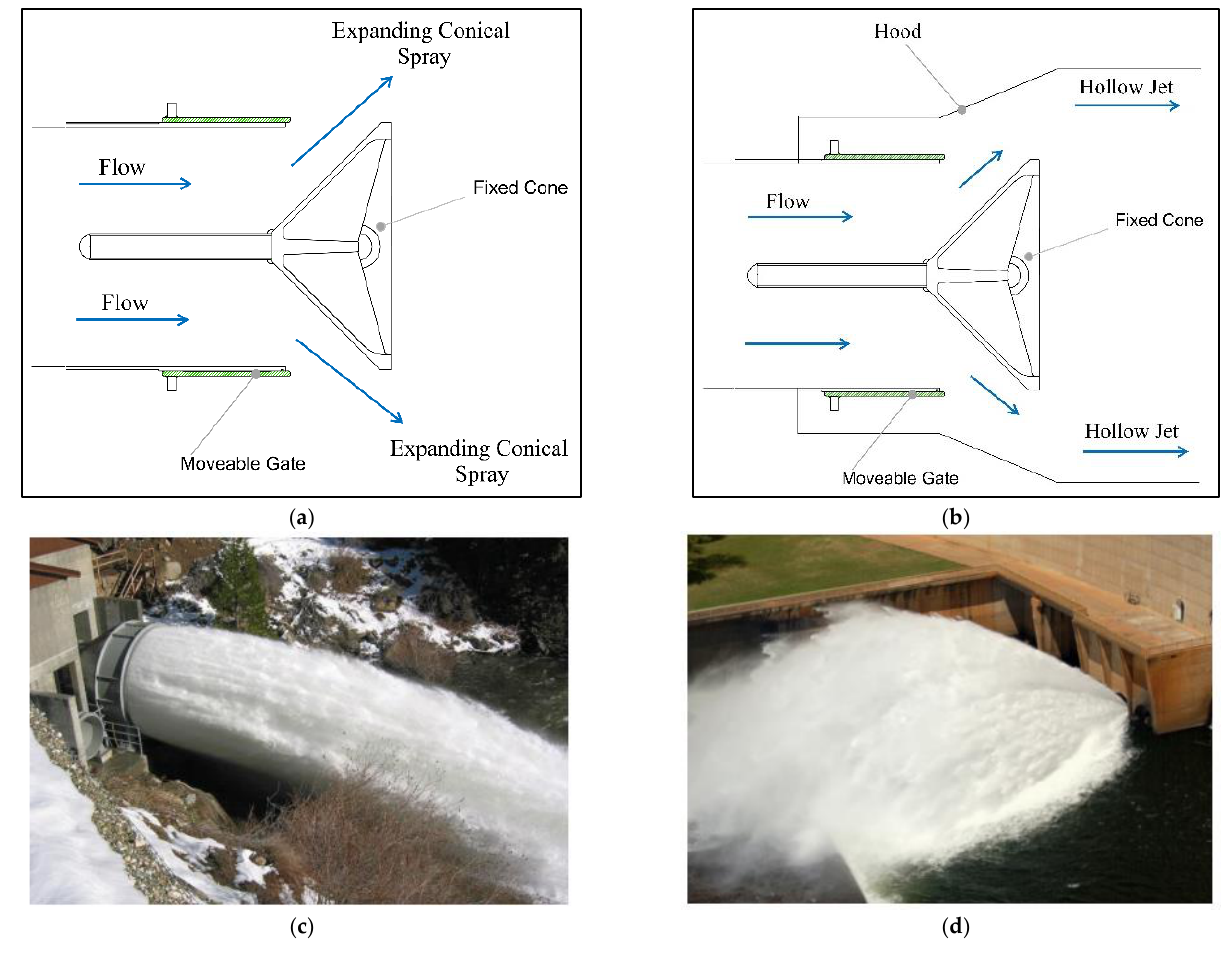
Figure 1. The Sectional view of typical ( a ) Howell – Bunger with hood; ( b ) Howell – Bunger without hood; ( c ) Howell – Bunger with hood of Salt River and Lower Bear Reservoirs, CA, USA; and ( d ) Howell – Bunger without hood of Jozini Dam, South Africa.